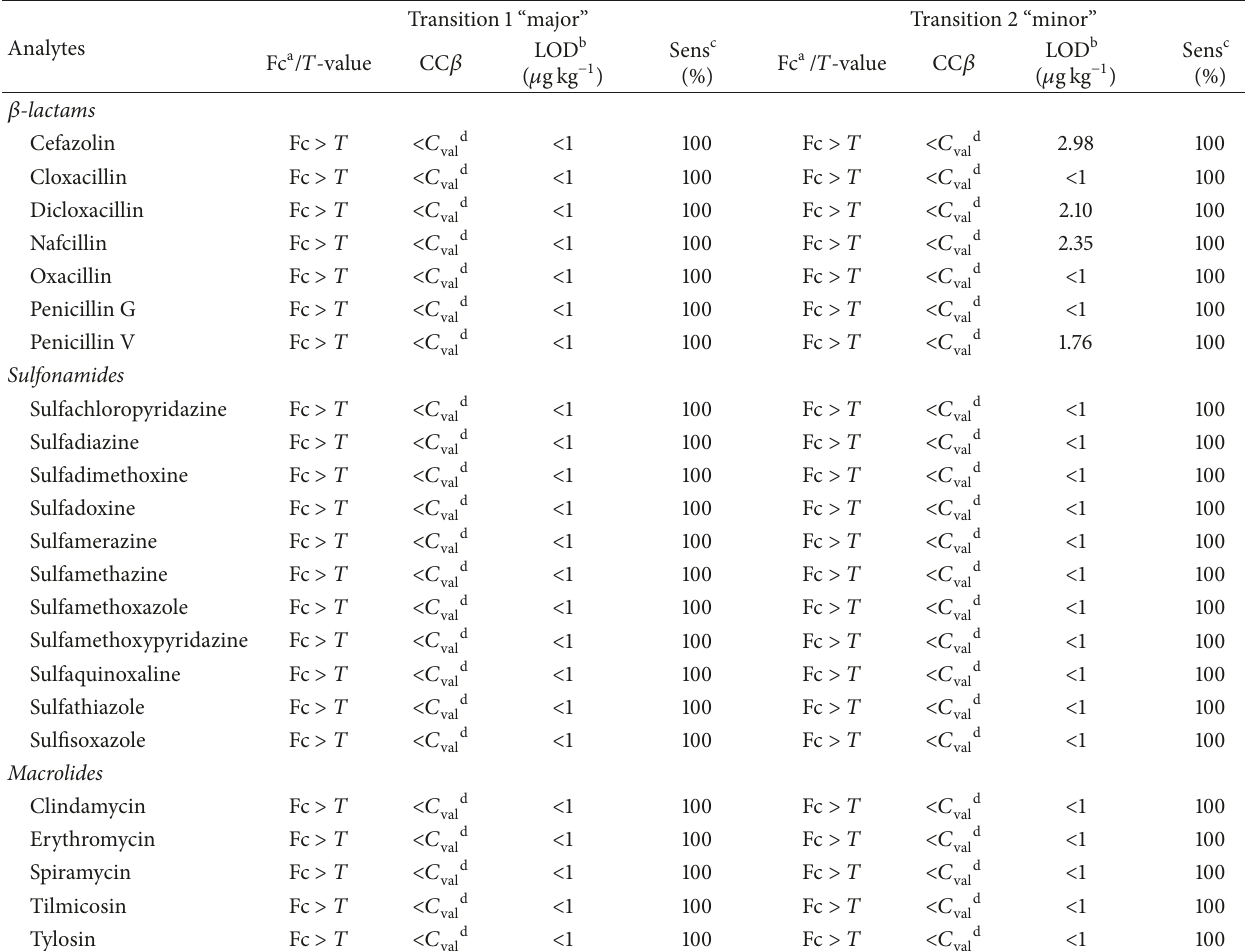
Table 5: Results of the method validation for 𝛽 -lactams, sulfonamides, and macrolides families.